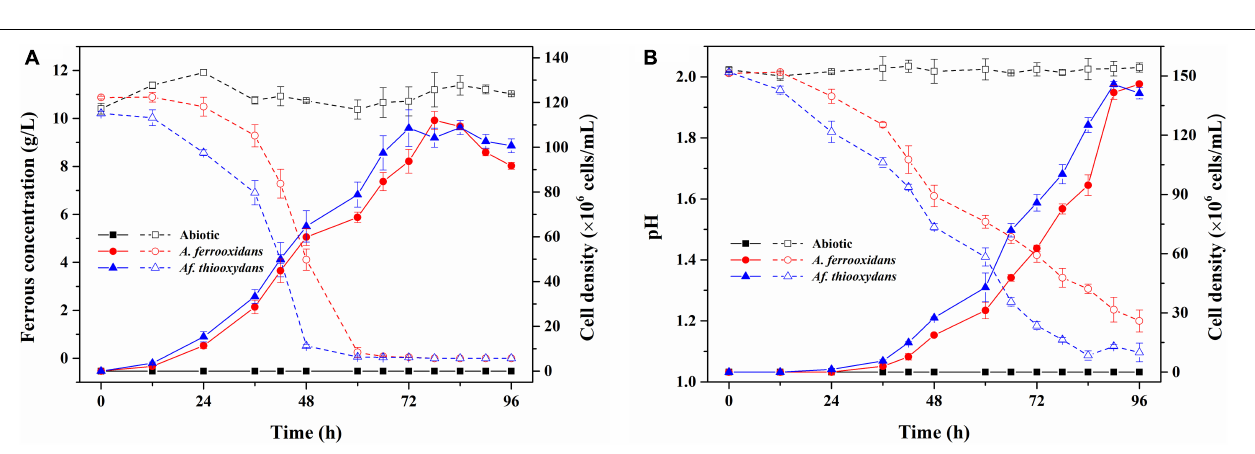
FIGURE 1 | Circular map of Af. thiooxydans ZJ (A) and the classification of COG functions (B) . From outside to inside: rules for reads; CDS on sense DNA strand; CDS on antisense DNA strand; rRNA and tRNA; GC content; GC skew.